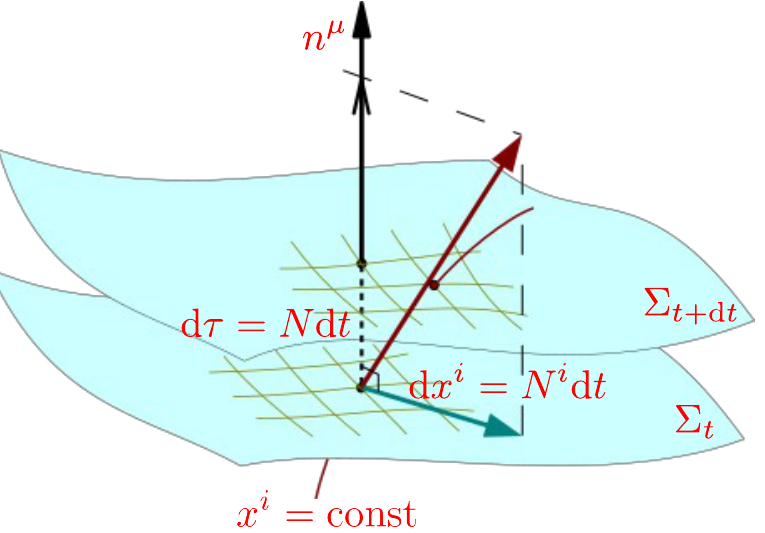
Figure 1. Spacetime is split into three-dimensional hypersurfaces Σ t labeled by a time parameter t , with the orthonormal vector n µ . The figure illustrates the various quantities involved in the 3 + 1 split of the metric expansion